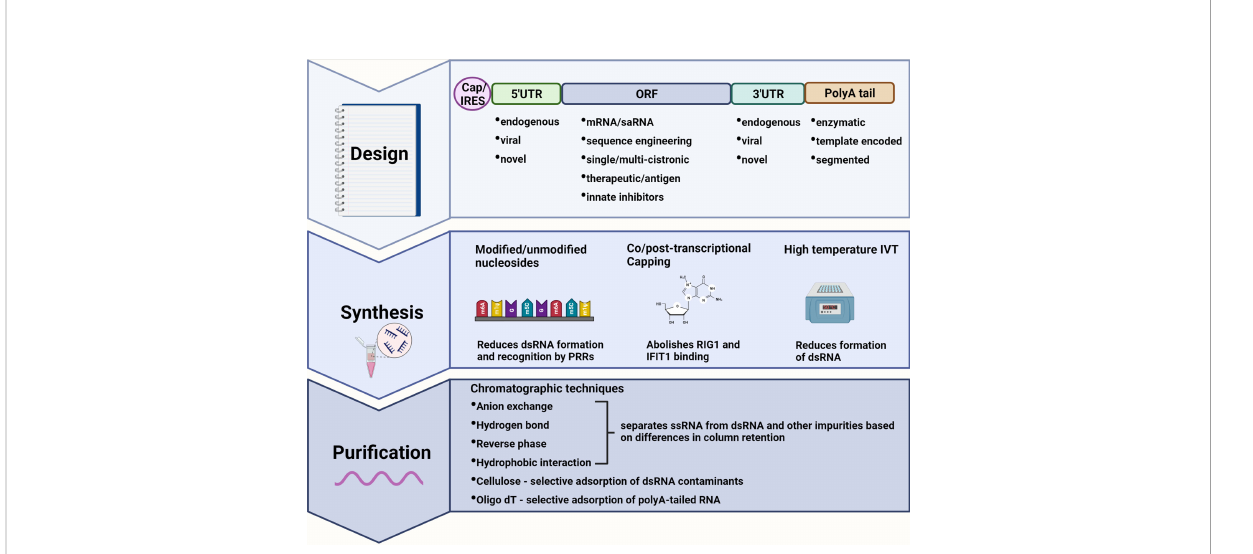
FIGURE 1 Immune modulating modi fi cations to mRNA design, synthesis, and puri fi cation. Design: The mRNA transcript can be designed to incorporate elements of reduced immunogenic potential. A 5 ’ cap abolishes recognition by cytosolic pattern recognition receptors (PRRs) whereas an internal ribosome entry site (IRES) allows for cap-independent translation during interferon-induced translational shut-off. Untranslated regions (UTRs) from highly expressed endogenous genes, or alphavirus derived conserved sequence elements (CSEs) in the case of self-amplifying RNAs (saRNAs), ensure ef fi cient translation of the mRNA. Highly structured viral CSEs are also capable of evading PRR recognition and binding. The sequence encoding therapeutic proteins or antigens can be codon optimized to deplete uridine thus reducing recognition by PRRs. A polyA tail enhances mRNA stability and translational ef fi ciency with template encoded polyA tails inhibiting the formation of double-stranded (dsRNA) by- products. Synthesis: Modi fi ed nucleotides may be incorporated during in vitro transcription (IVT) to produce transcripts that evade PRR recognition while also reducing the formation of dsRNA. Capping can be performed co/post-transcriptionally to abolish binding by RIG-I and IFIT1. IVT reactions performed at higher temperatures also reduce the formation of dsRNA by-products. Puri fi cation: dsRNA as well as other impurities can be separated from single-stranded RNA (ssRNA) by a variety or combination of chromatography-based puri fi cation techniques enabling the recovery of pure mRNA product with reduced immunogenicity. Created using